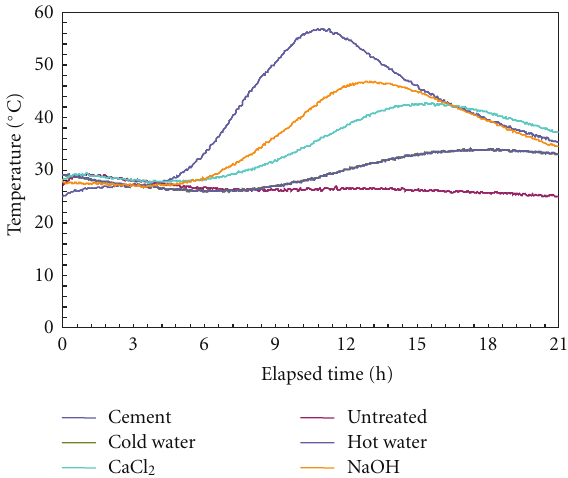
Figure 1: Hydration curve of the mixture between untreated/ treated coir fibre and cement.